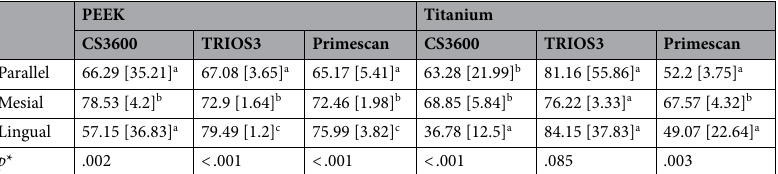
Table 1. Within-tolerance (%) measurements according to implant angulation, scan body materials, and intraoral scanners. Data are presented as median [interquartile range]. Values with the same superscript letters in each column are not significantly different from each other (Mann–Whitney U test followed by Bonferroni correction for multiple comparisons). PEEK polyetheretherketone. *Kruskal–Wallis